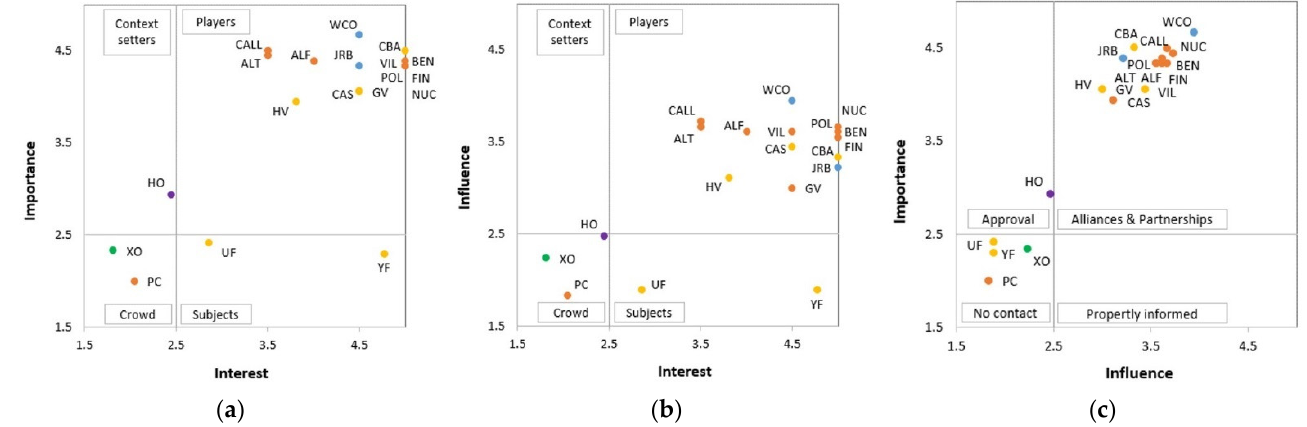
Figure 6. Importance and influence plots regarding stakeholders’ behavior. ( a ) provides im- portance-interest matrix; ( b ), influence-interest matrix; and ( c ) importance-influence matrix. Legend importance/influence: 0 (Do not know/no answer), 1 (dispensable/awful), 2 (unhelpful/bad), 3 (complementary/neither right nor wrong), 4 (necessary/good), and 5 (essential/excellent). Note: color shows stakeholder group members: government officials (orange), water managers (blue), agricultural sector (yellow), tourism sector (purple), and environmental sector (green). Government officials (GV, PC, ALF, ALT, BEN, CALL, FIN, NUC, POL and VIL); water managers (JRB and WCO); agricultural sector (CBA, CAS, HV, YF, UF); tourism sector (HO); environmental sector (XO).